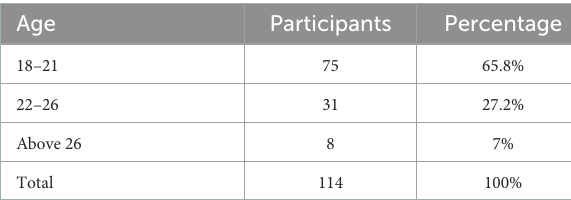
TABLE 1 Demographic